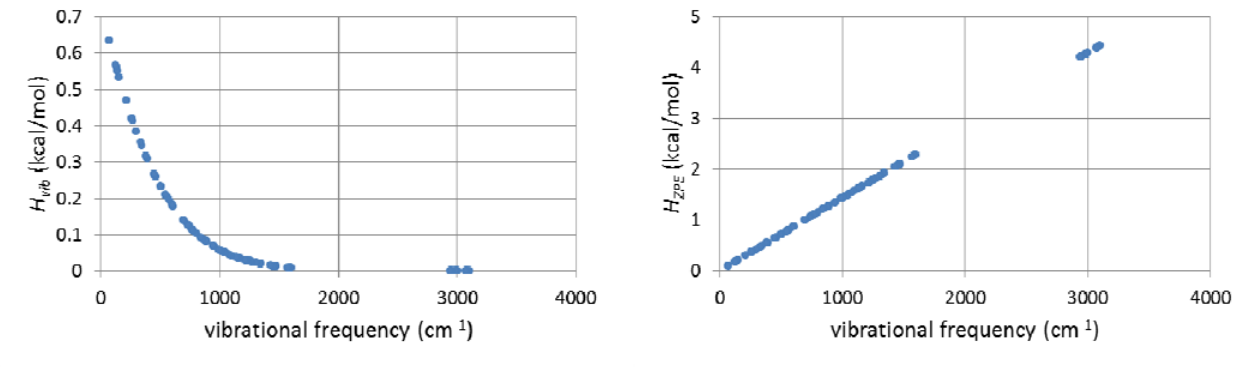
Figure 9. B3LYP/6-31G(d,p) H state of biphenyl 7 computed at 368